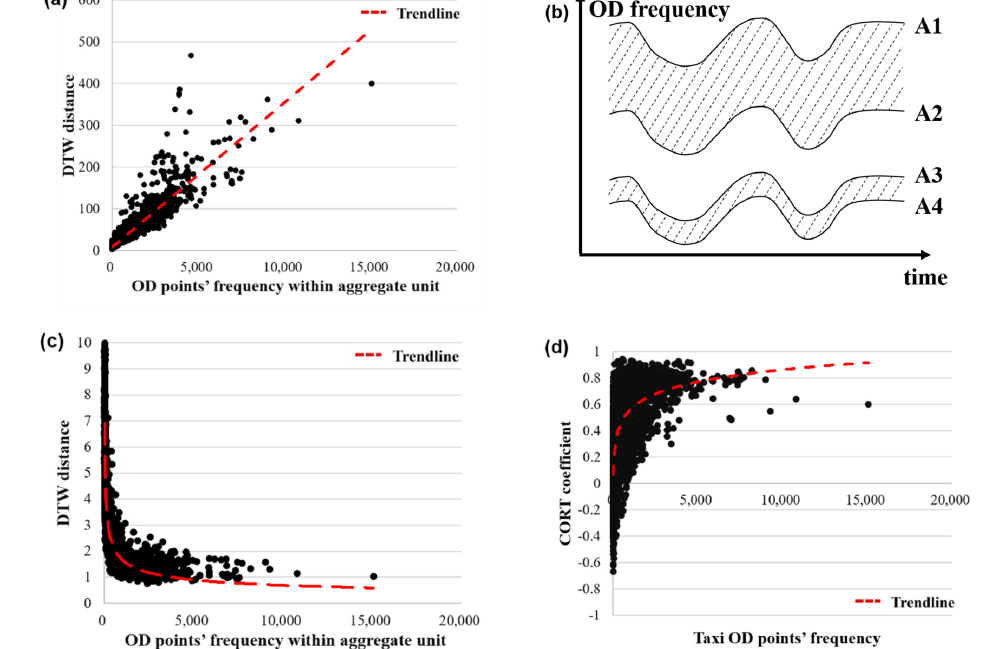
Figure 5. Time series similarity measurement: ( a ) the unnormalized correlation between the DTW distance and the OD frequency, ( b ) the differences in the absolute distances within the same series, ( c ) the normalized correlation between the DTW distance and the OD frequency, and ( d ) the correlation between the CORT coefficient and the OD frequency.